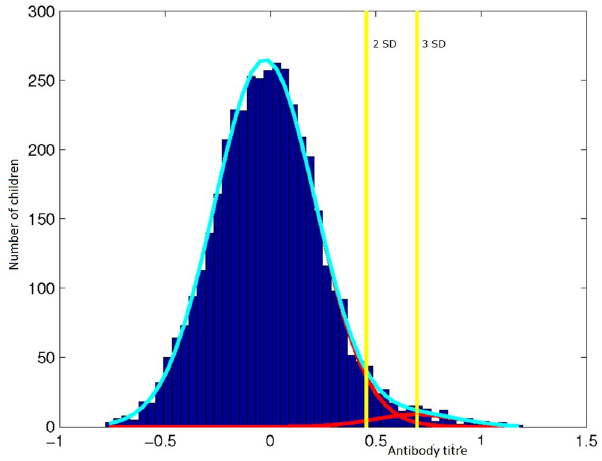
Figure 3. Two-component model distribution of antibody titres (yellow bars: 2 and 3 SD).